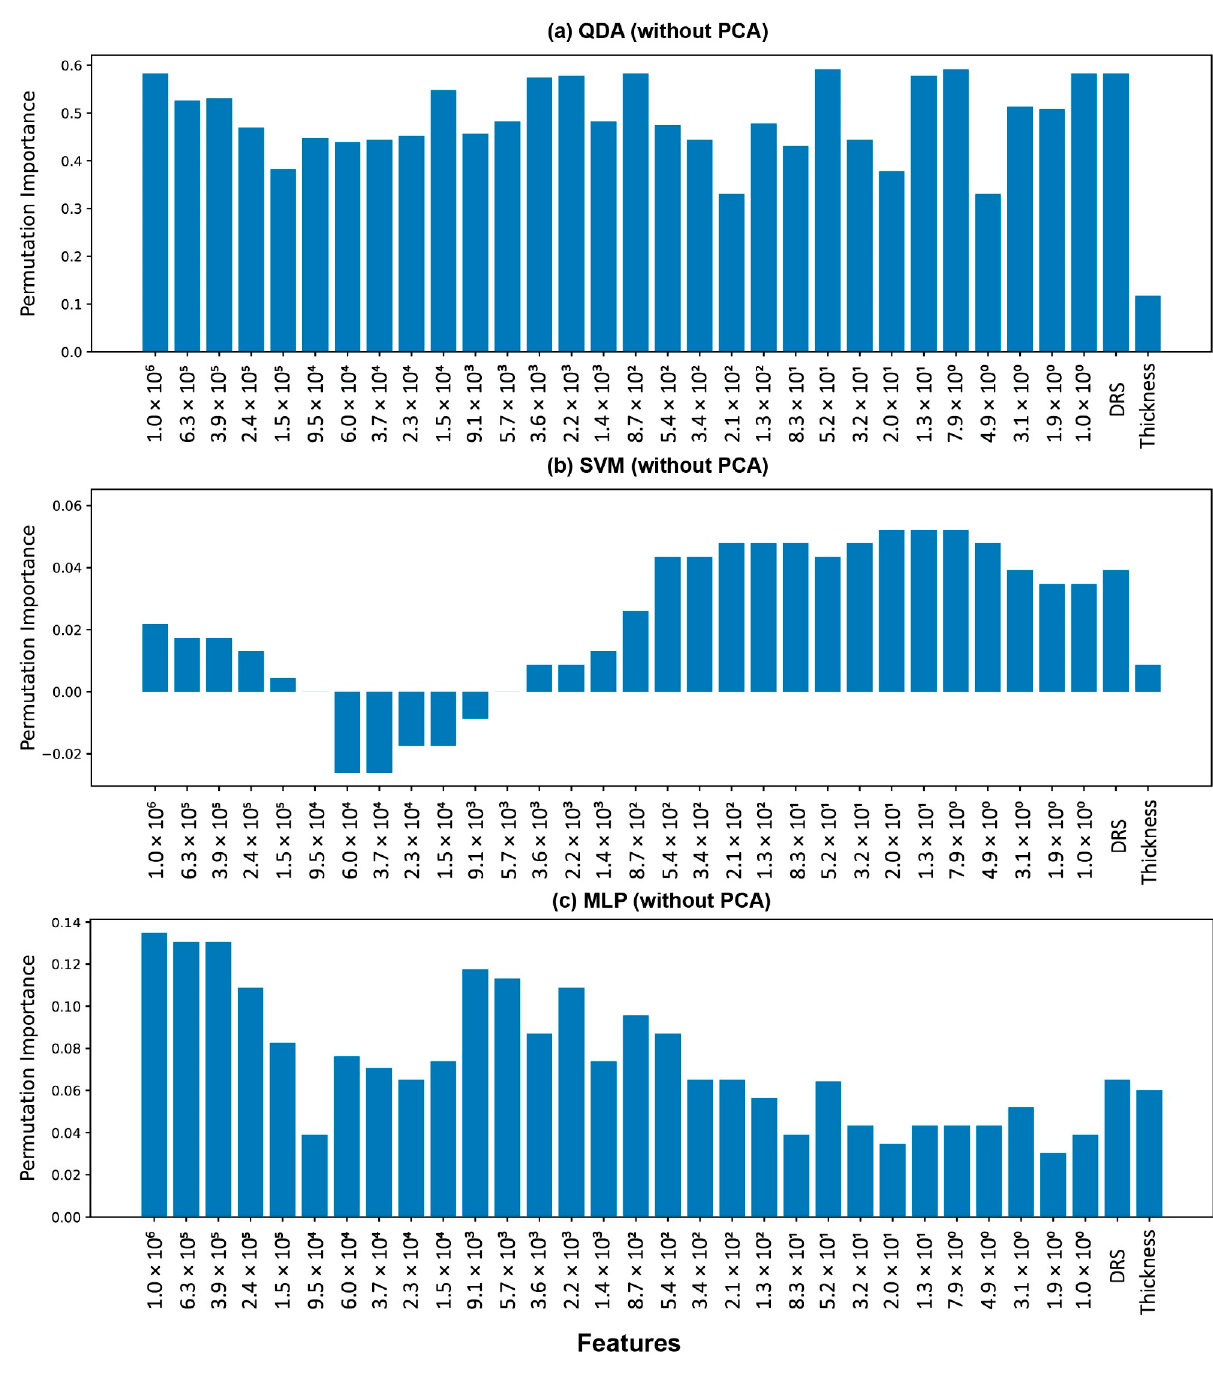
Figure 14. Permutation importance (PI) values for features used in developing ( a ). QDA, ( b ). SVM, and ( c ). MLP, without PCA.